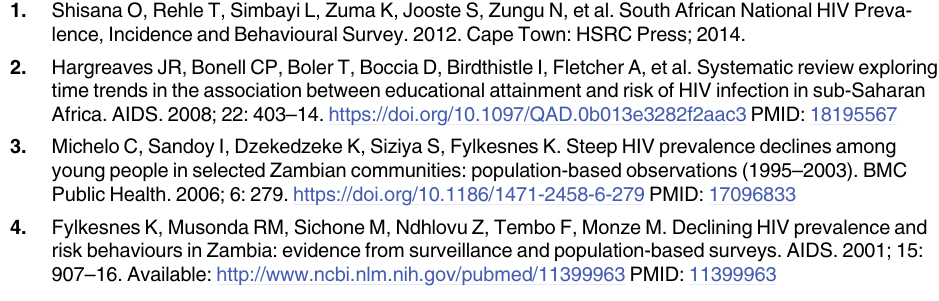
S1 Table. Crude odds ratio of the association between interest in education and HIV, HSV-2 and Sexual risk